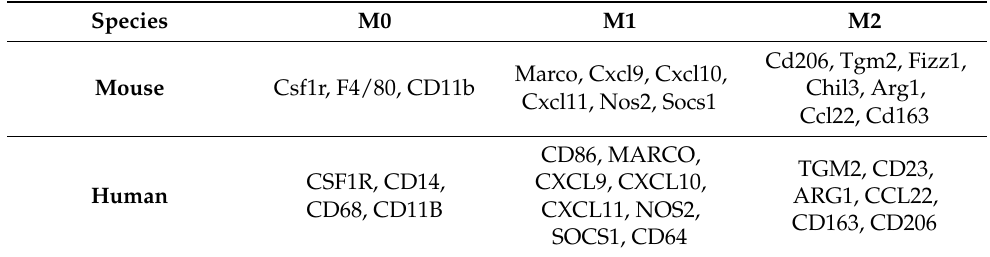
Table 1. Macrophage polarization markers on M0, M1 and M2 mouse and human